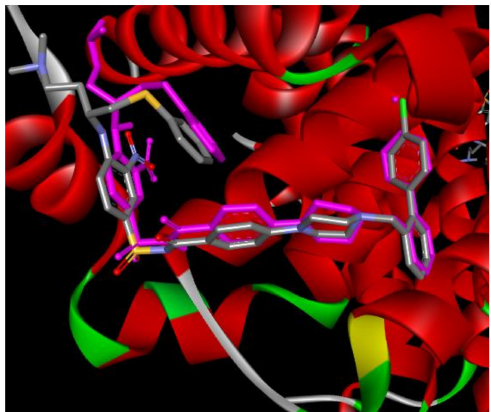
Figure 8. Real and predicted (pink-colored) position of N3C inside Bcl-xl protein (PDB: 2YXJ, RMSD =